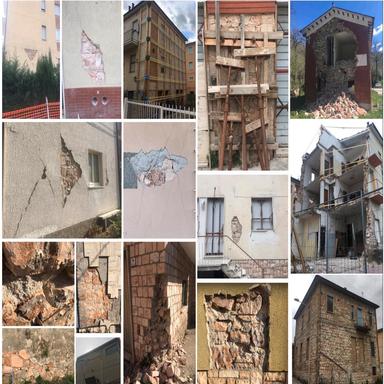
Damage on "Scaglia Rossa" masonry structures after Central Italy seismic sequence of 2016-'17.